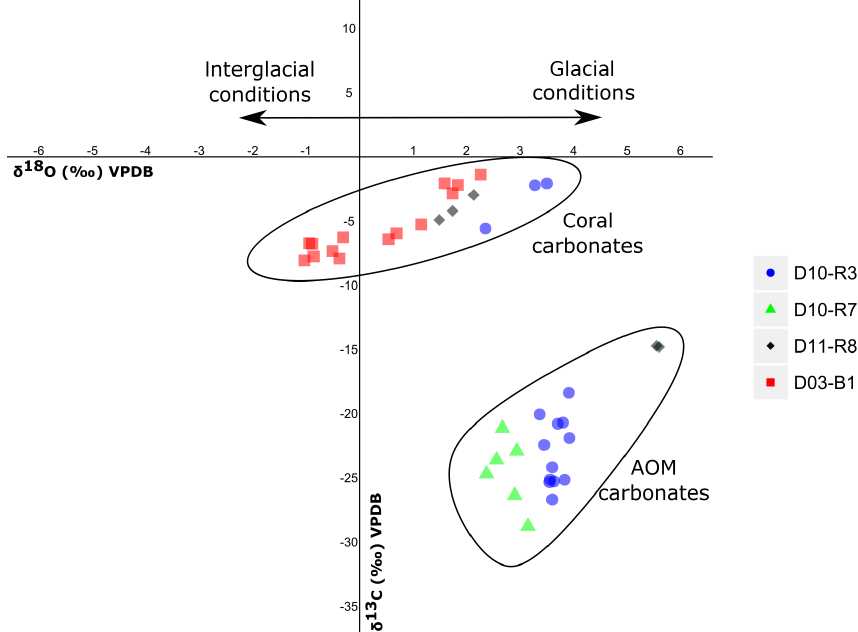
Figure 9. Stable carbon and oxygen isotopes ( δ 13 C, δ 18 O) of samples from the Al Gacel MV and the northern Pompeia Coral Ridge (see Table 3 and Fig. 7 for precise sampling points).